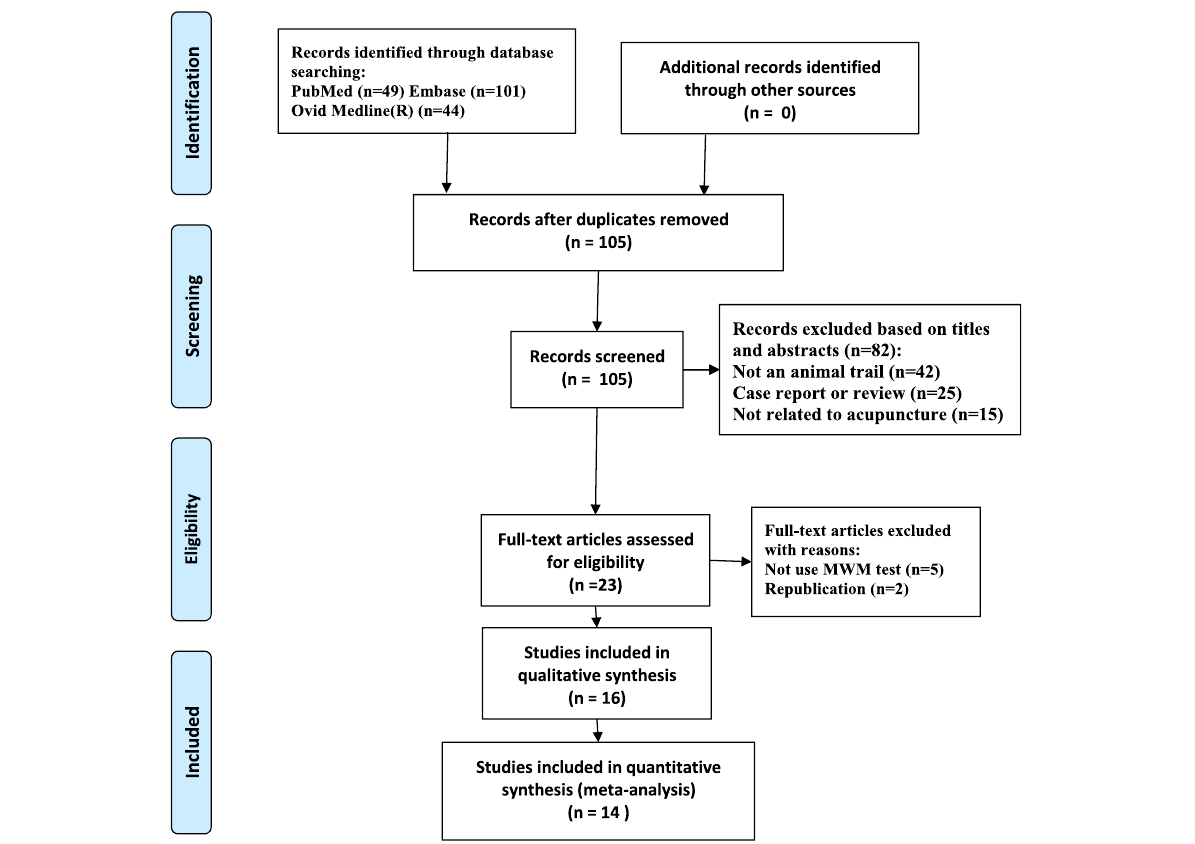
Fig. 1 Flow diagram of the study selection process. MWM:Morris water